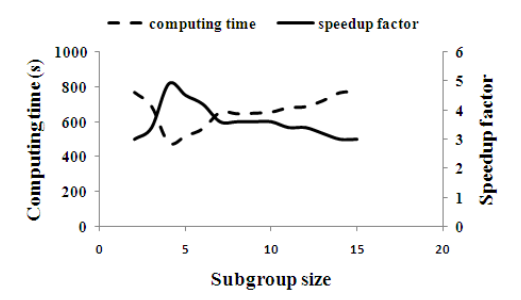
Fig. 4. Relationship between the parallel computation performance of SR-PDP and subgroup